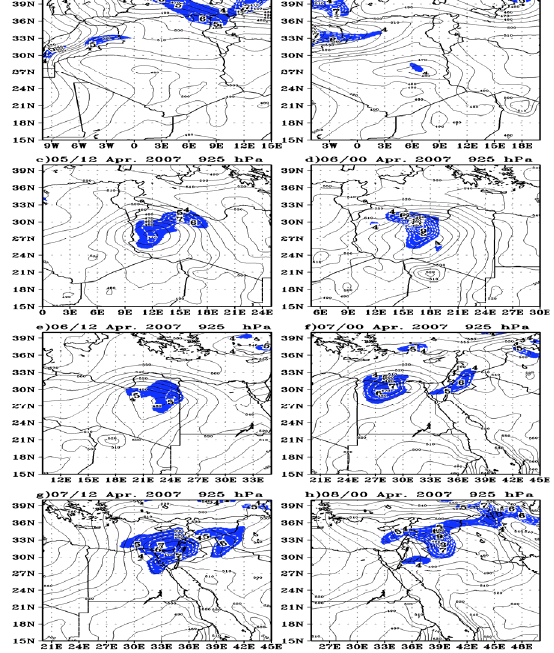
Figure 9. The 925 hPa geopotential height with 10 gpm contour intervals (solid lines) and isotachs of isallobaric wind (shaded areas) ≥ 4 m/s, every 1 m/s (dashed lines), at 12Z and 00Z for 4–8 April 2007.